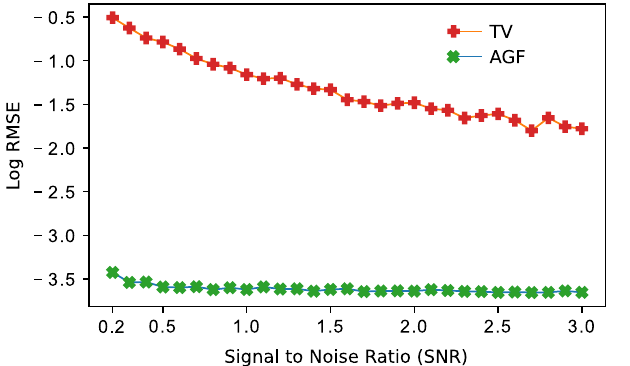
Figure 7. The graph shows the error obtained using the Adaptive Gabor Filters (AGF) approach, shown here, and the TV filtering approach shown in ref. 16. For clarity, the error is in logarithmic scale.